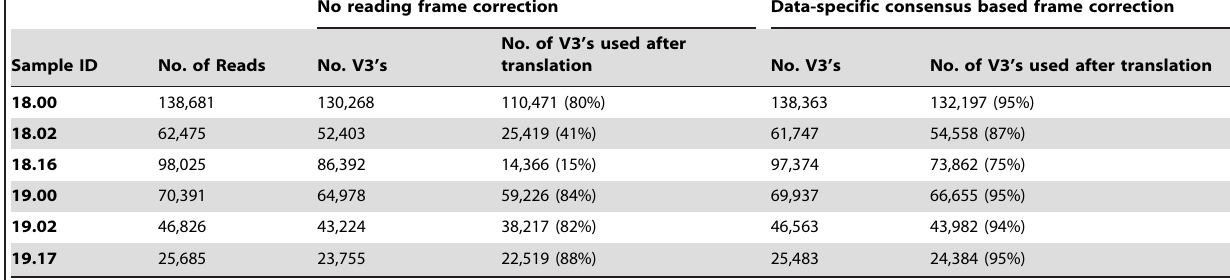
Table 5. Reference template